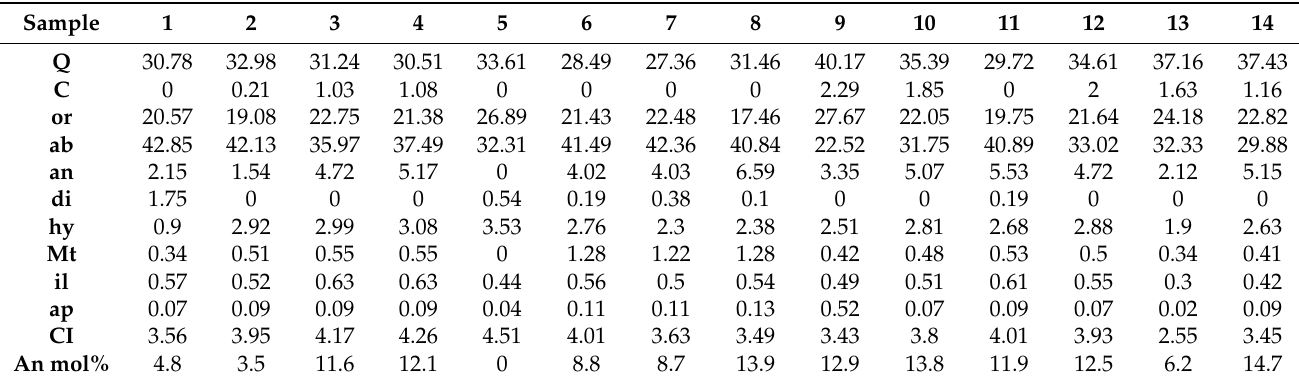
Table 2. CIPW Norms calculated from the major oxides of the studied granitic